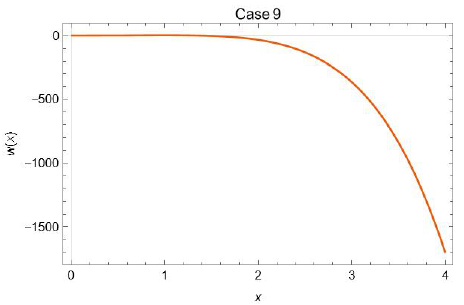
Figure 6. We let a 0 = 1, a 1 = 1, a 2 = 1, a 3 = 1, a 4 = 1, α = 1